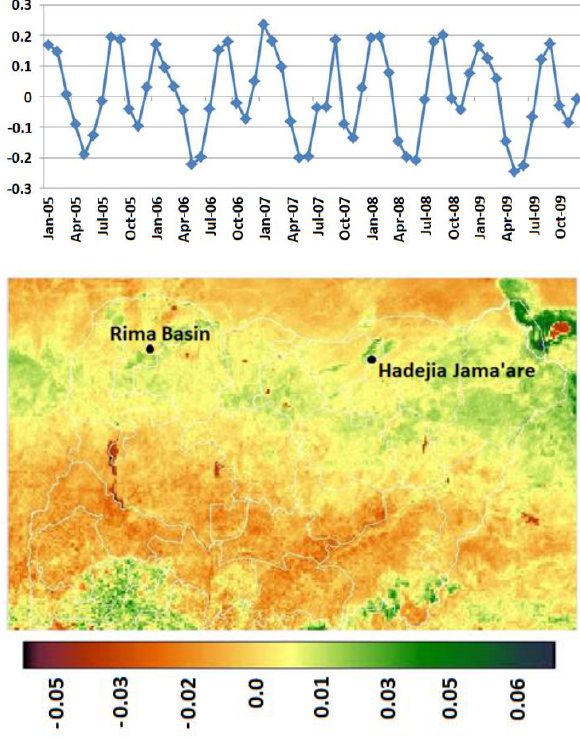
Figure 5. Component 3 image and its corresponding graph of